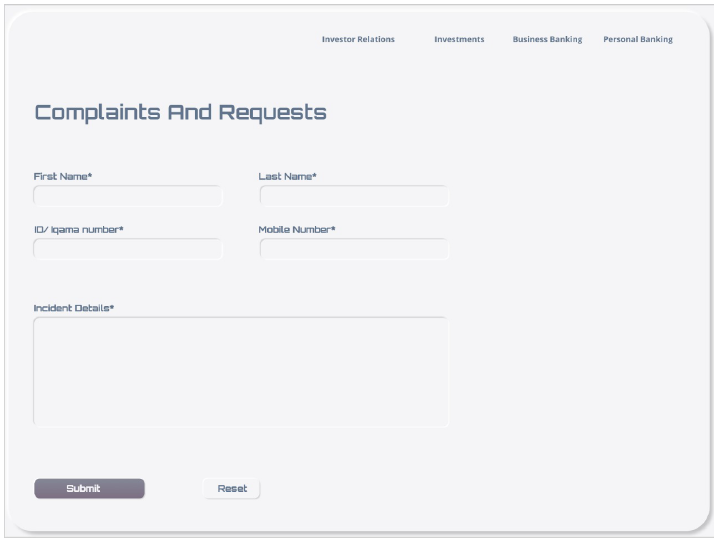
Figure 5. A prototype of the recipient web-based application to submit caller requests and therefore interact with the blockchain network.